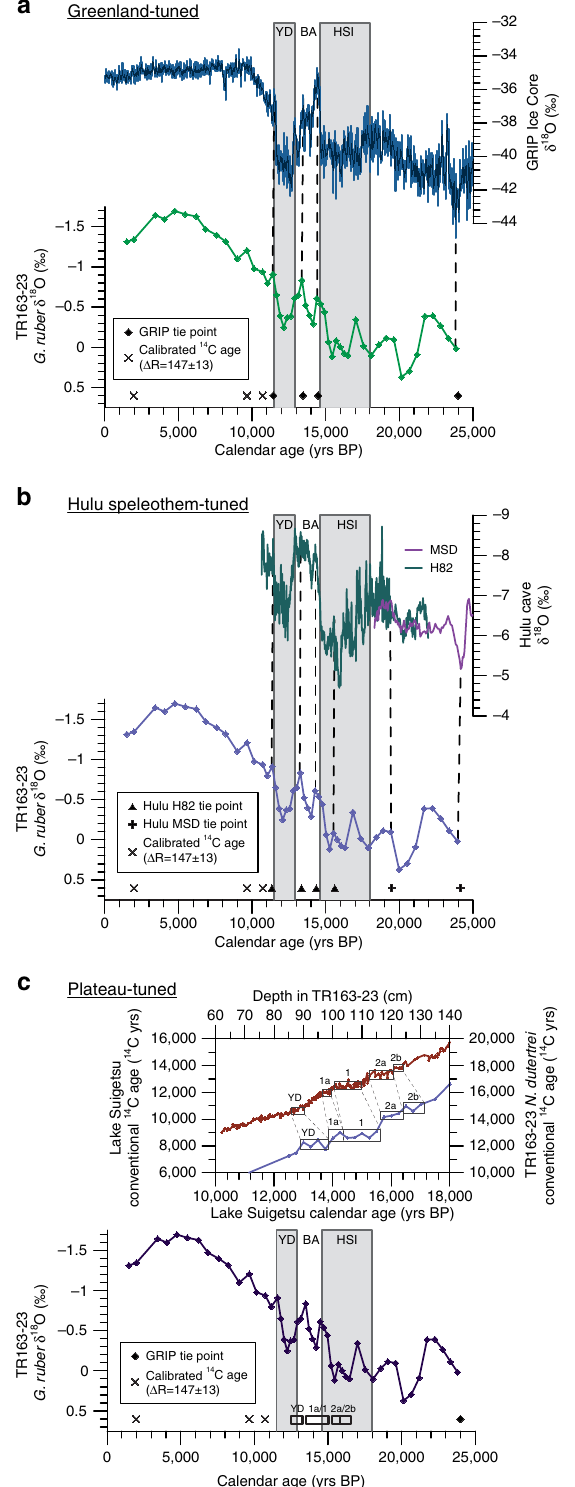
Figure 3 | Construction of TR163-23 tuned chronologies. ( a ) Tie point ages and age uncertainty for the TR163-23 G. ruber d 18 O record were constrained from the GRIP ice core d 18 O record 37–39 using ETP 43 . Calibrated radiocarbon ages used in the final age model are indicated with an X and ETP-derived tie-points are indicated with a diamond. ( b ) ETP constrained deglacial tie-points from the H82 speleothem and glacial tie- points from the MSD speleothem d 18 O records 40–42 are indicated by a triangle. As with the Greenland-tuned age model, calibrated radiocarbon ages are used to date the Holocene portion of the core in the final Bayesian- derived age model. Dashed lines connect TR163–23 d 18 O data points to corresponding Hulu speleothem and Greenland ice core reference record events used as tie points. ( c ) Five 14 C-plateaus were identified in the TR163–23 N. dutertrei radiocarbon record (blue) that correspond to 14 C- plateaus previously identified in the Lake Suigetsu atmospheric 14 C record (red) 63 by Sarnthein et al. 30 A hiatus between the Younger Dryas plateau and plateau 1a was included in the final Bayesian-derived age model. In addition, a Greenland ice core tie point was used to constrain the LGM portion of the core. ETP, elastic tie-pointing; LGM, last glacial